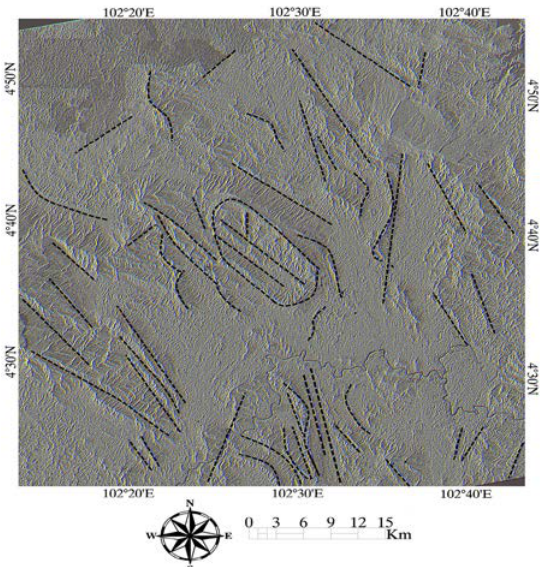
Figure 2. Fused image of N-S (0 ◦ ), NE-SW (45 ◦ ), and NW-SE (135 ◦ ) directional filters applied on the HV polarization image for the study area.